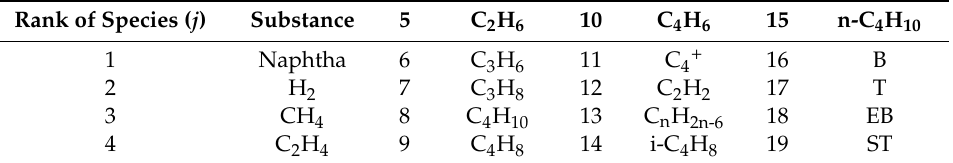
Table 3. List of relevant